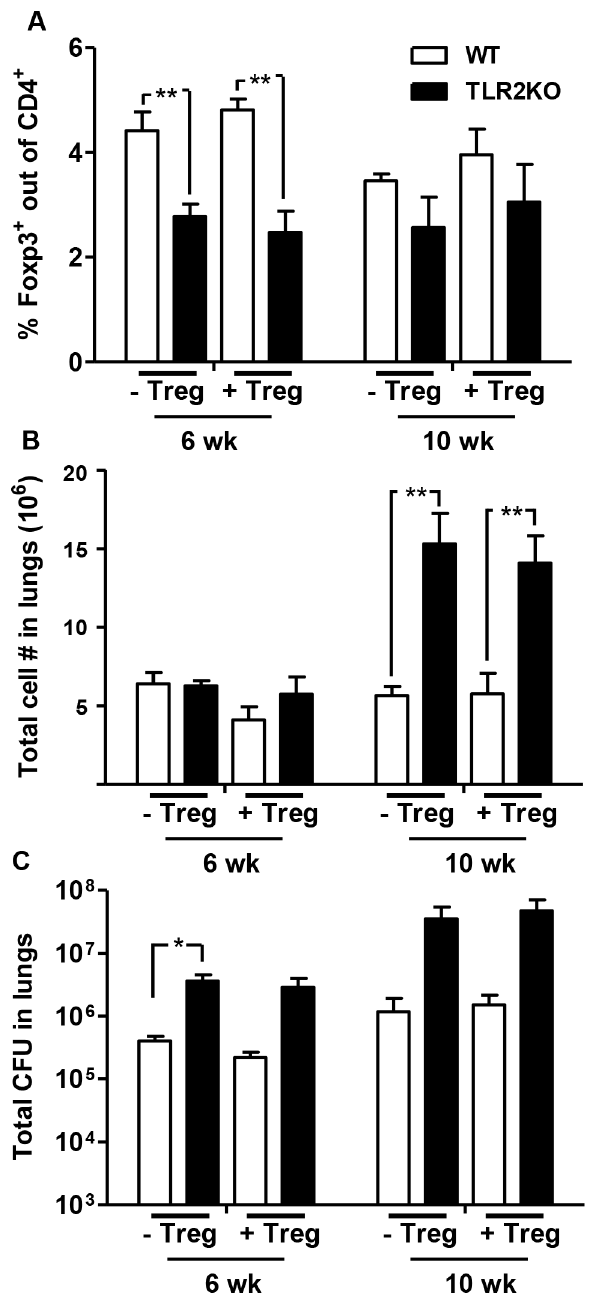
Figure 4. Treg accumulation and disease progression in TLR2KO mice is not altered by the transfer of WT Tregs. CD4 + CD25 + Tregs purified from naı¨ve WT mice were transferred to TLR2KO and WT control mice one day prior to and 4 weeks after Mtb infection (0.5 6 10 6 cells per mouse for each transfer). Non-recipient WT and TLR2KO control mice were infected at the same time. Single cell suspensions were prepared at the indicated time points after Mtb challenge. Lung cells were stained with antibodies against CD4 and Foxp3, followed by flow cytometric analysis. Expression of Foxp3 is presented as a percentage of the CD4 + cell population (A). Total number of viable cells in the lungs was determined by trypan blue exclusion method (B). Bacterial burden in the lungs was determined by plating serial dilutions of lung homogenates onto 7H11 agar plates (C). Data include 4–5 mice per group and are presented as mean 6 SEM. *, p , 0.05; ** , p , 0.01.